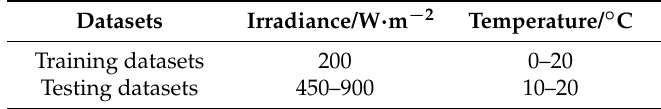
Table 3. The range of environmental parameters in simulation